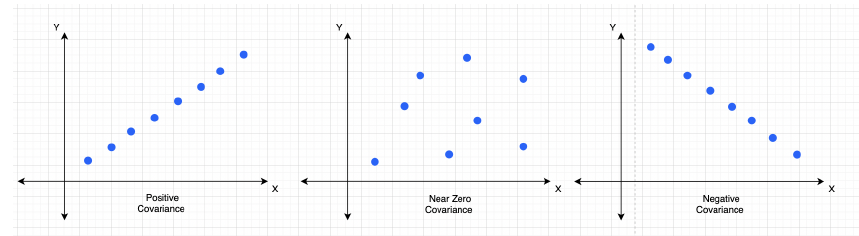
Figure 3. Covariance and their